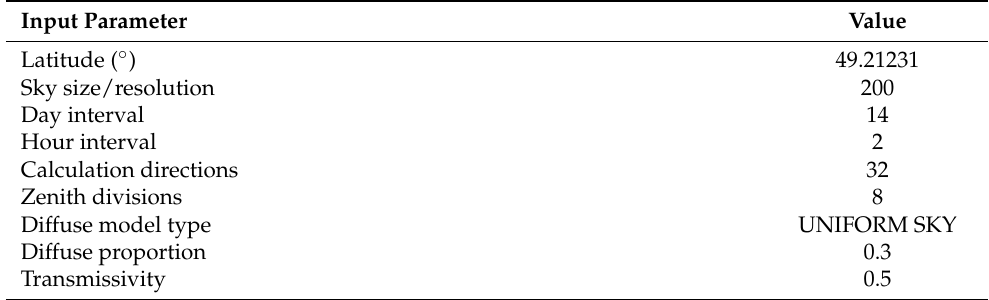
Table 2. Input parameters used for calculation of solar radiation using the Area Solar Radiation tool.